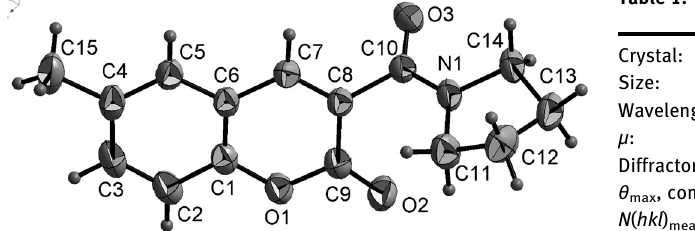
Table  : Data collection and